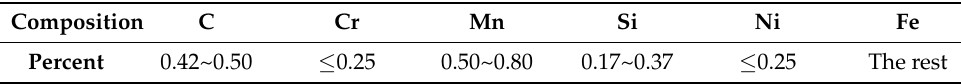
Table 1. Chemical compositions of the 45 steel substrate (wt%).